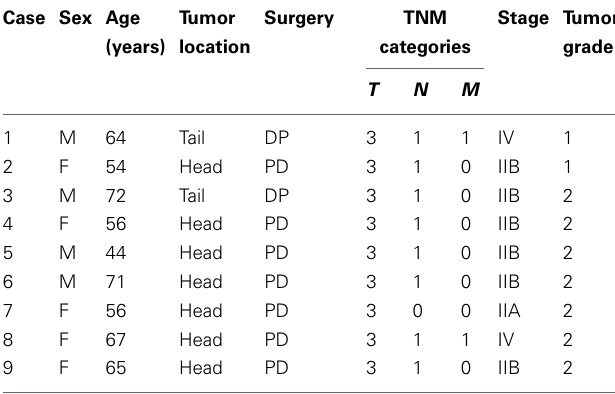
Table 1 | Baseline characteristics of patients with resected pancreatic